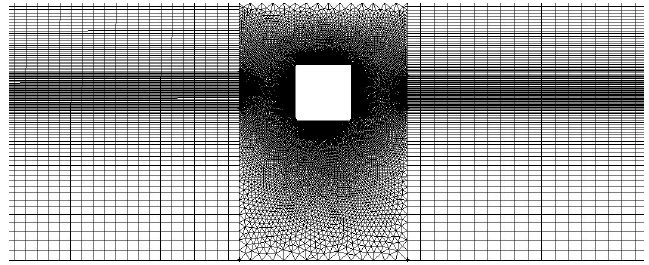
Figure 2. Mesh structures of numerical wave tank (NWT).